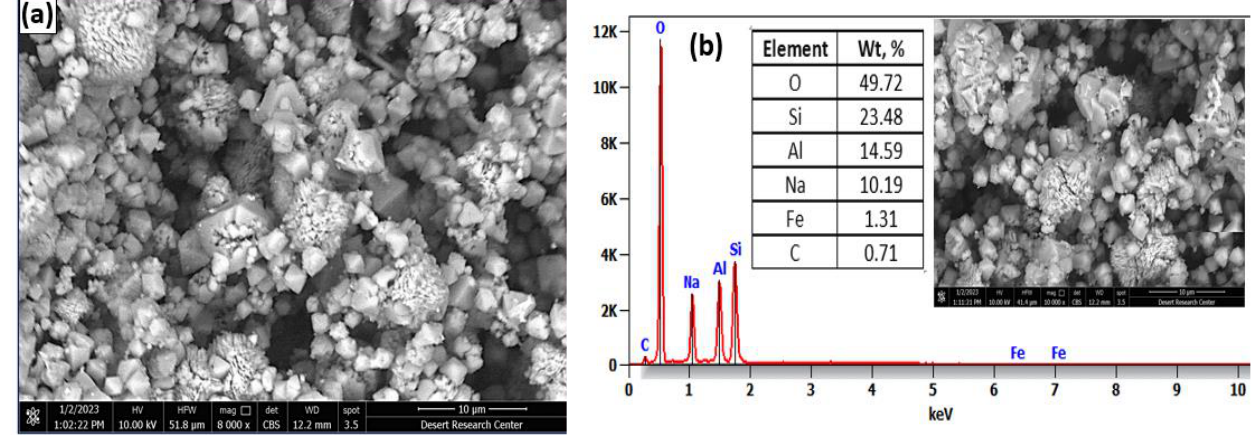
Figure 9. SEM image of synthesized zeolite (8000 × magnification) ( a ) and the EDS element analysis (10,000 × magnification) ( b ).